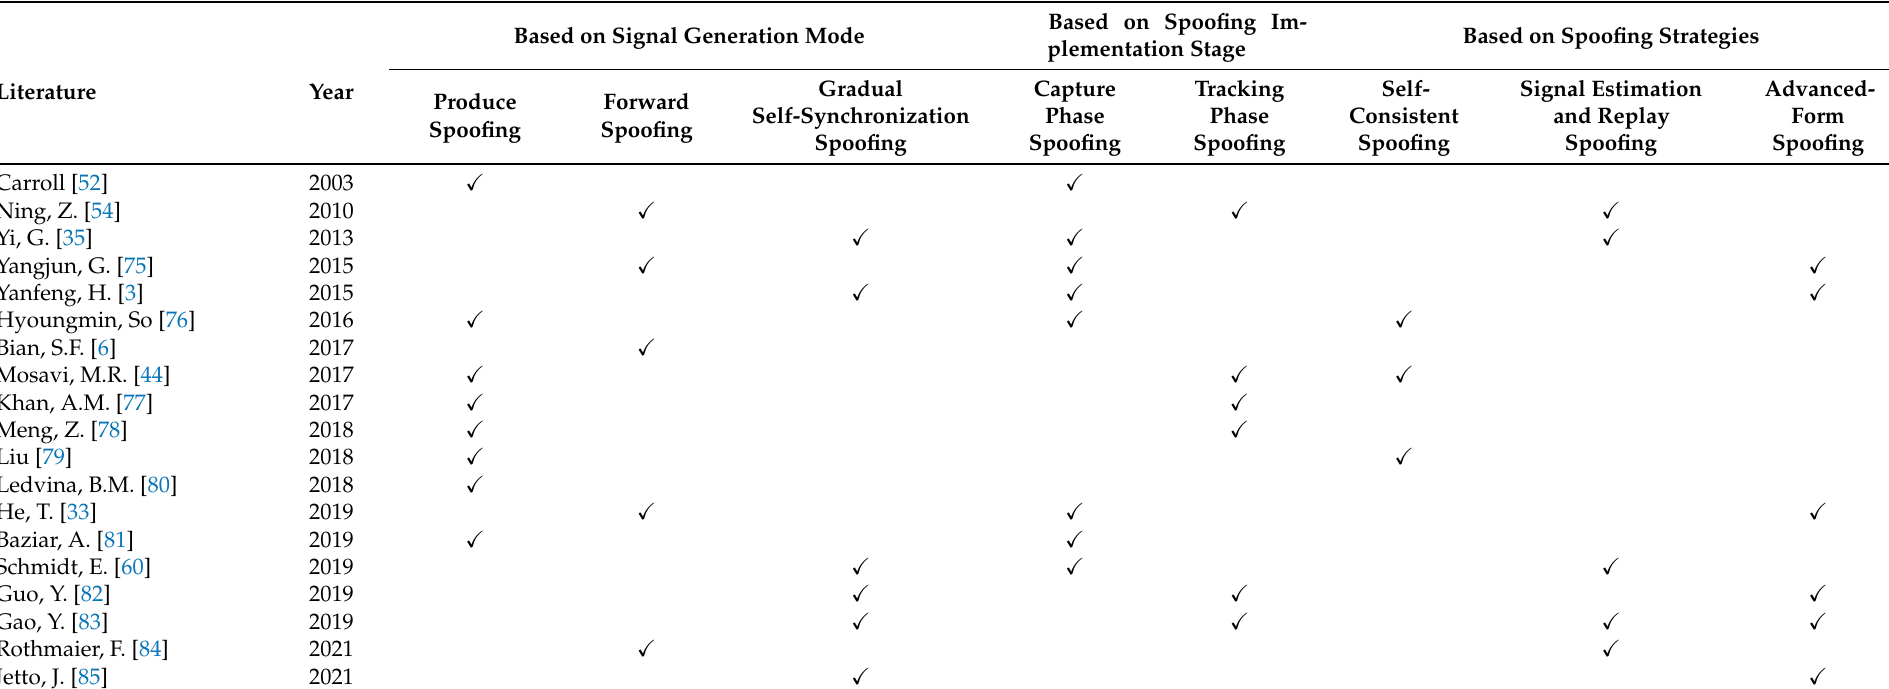
Table 2. Classification of GNSS spoofing